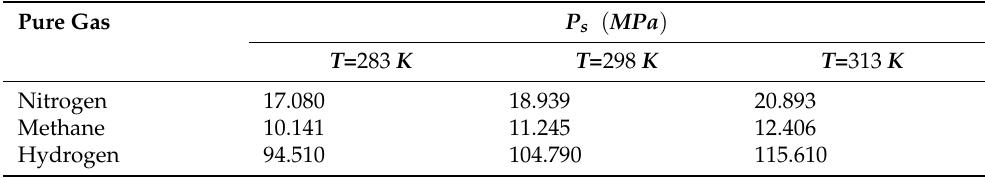
Table 3. Pseudo-vapour pressures for the different